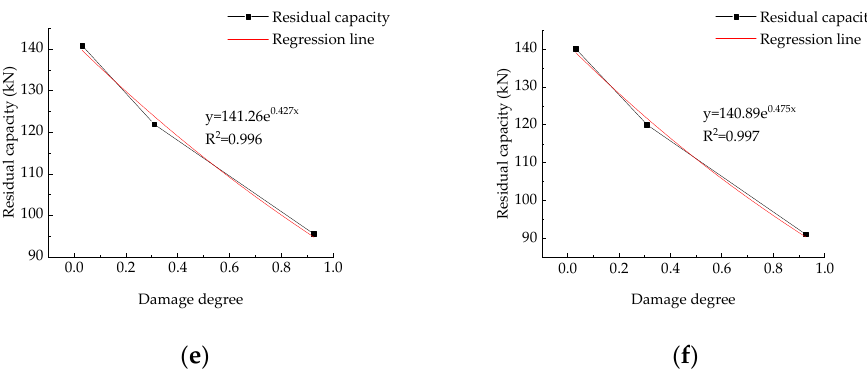
Figure 27. The relationship between the damage degree and the residual ultimate load capacity under different fatigue cycles. ( a ) 0.5 million cycles; ( b ) 1 million cycles; ( c ) 1.5 million cycles; ( d ) 2 million cycles; ( e ) 2.5 million cycles; ( f ) 3 million cycles.